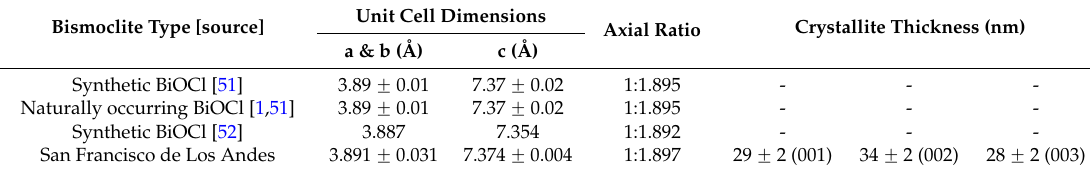
Table 6. Unit cell dimensions and axial ratio for naturally occurring and synthetic bismoclite. The Andes is also listed.